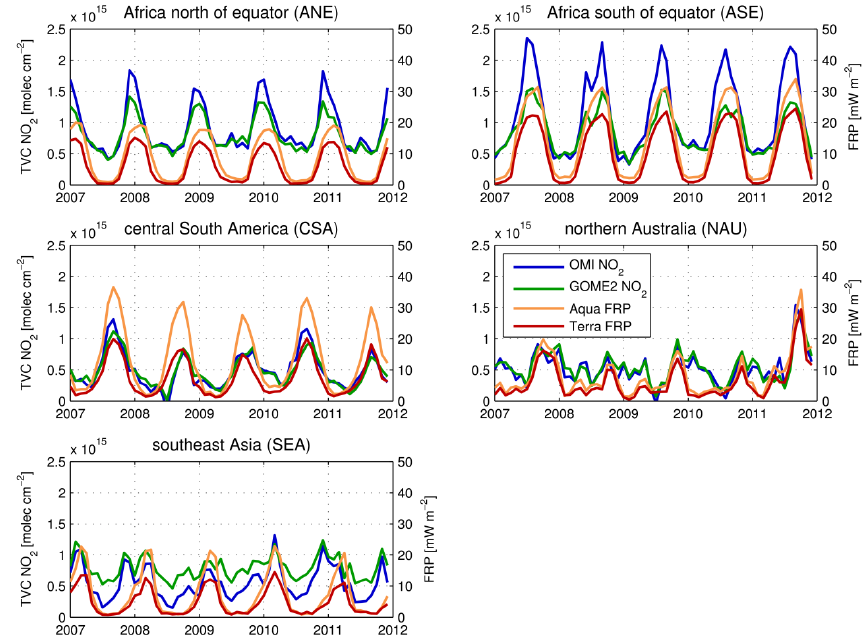
Figure 3. Temporal variability of MODIS Terra (red) and MODIS Aqua (orange) satellite-derived FRP and GOME-2 (green) and OMI (blue) derived TVC NO 2 for the selected regions as highlighted in Fig. 1 and defined in Table 1.